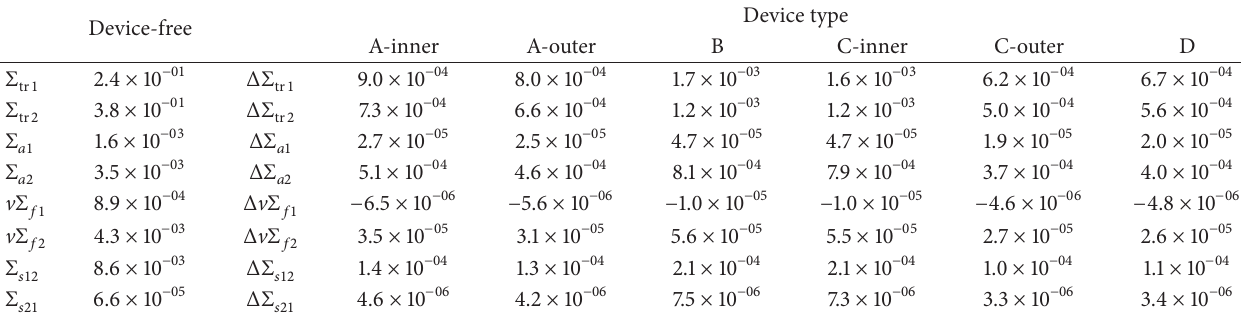
Table 4: Incremental cross sections of adjuster